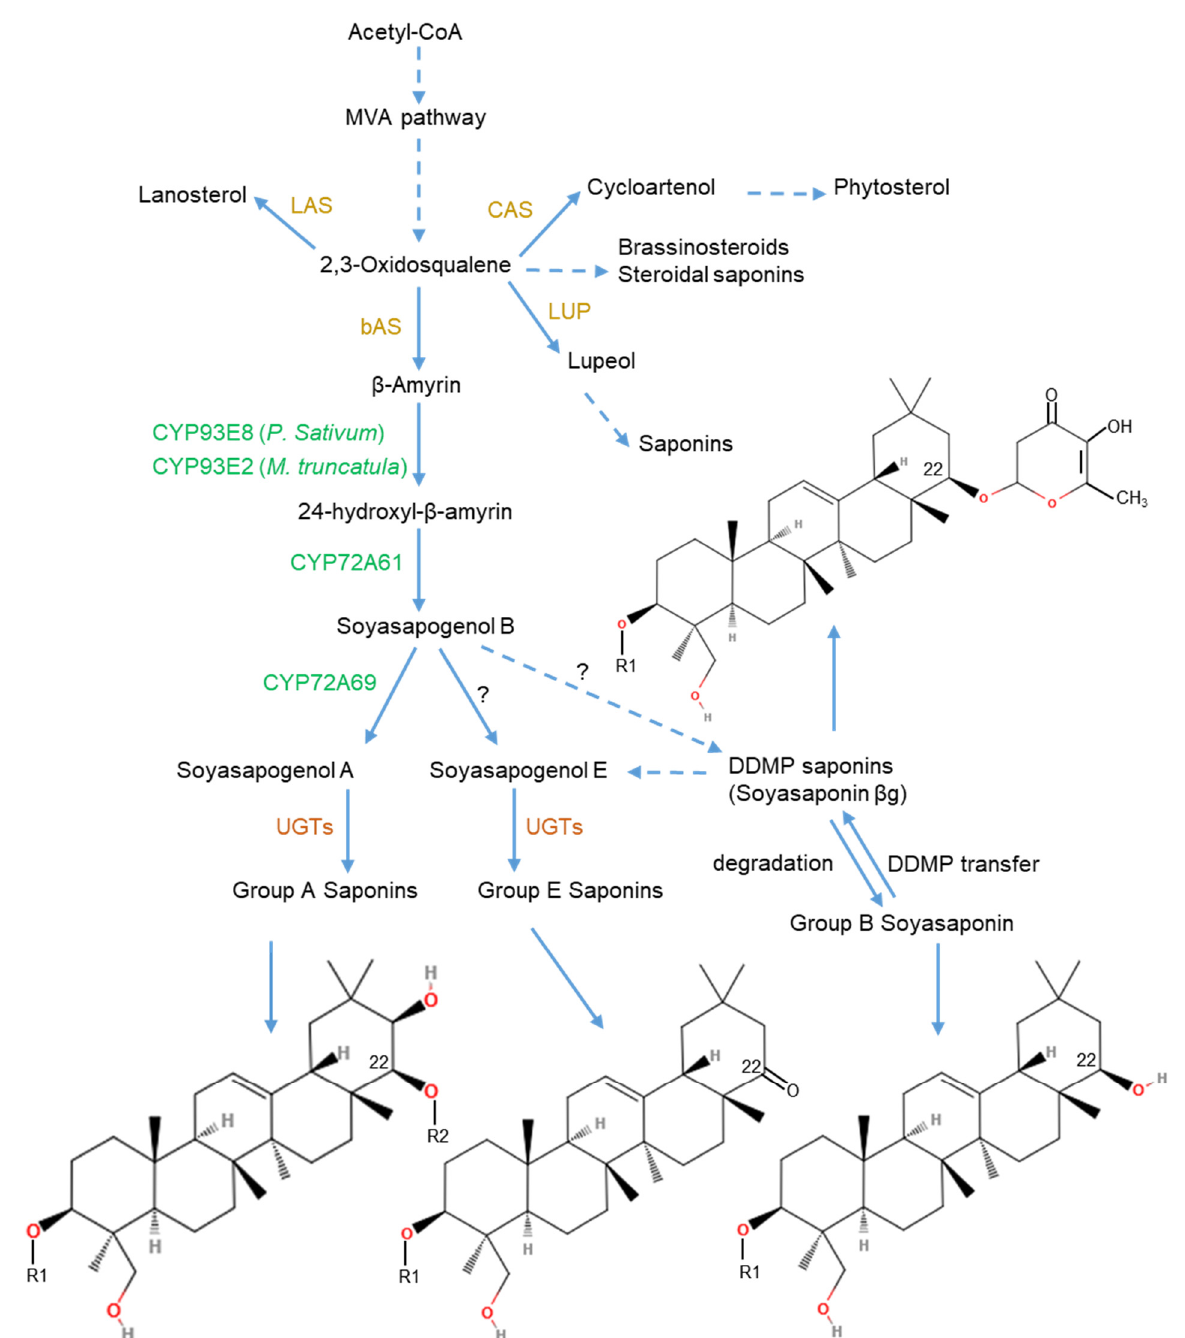
Figure 1. Soyasaponin biosynthesis pathway. MVA, mevalonate; bAS, β -amyrin synthase; CAS, cycloartenol synthase; LAS, lanosterol synthase; LUP, lupeol synthase; UGTs, uridine diphosphate- dependent (UDP) glycosyltransferases. Dashed lines indicate multiple steps involved. Compound structure was drawn using online tool molview, https://molview.org/ (accessed on 6 December 2022). Reference [9,11,35,39].